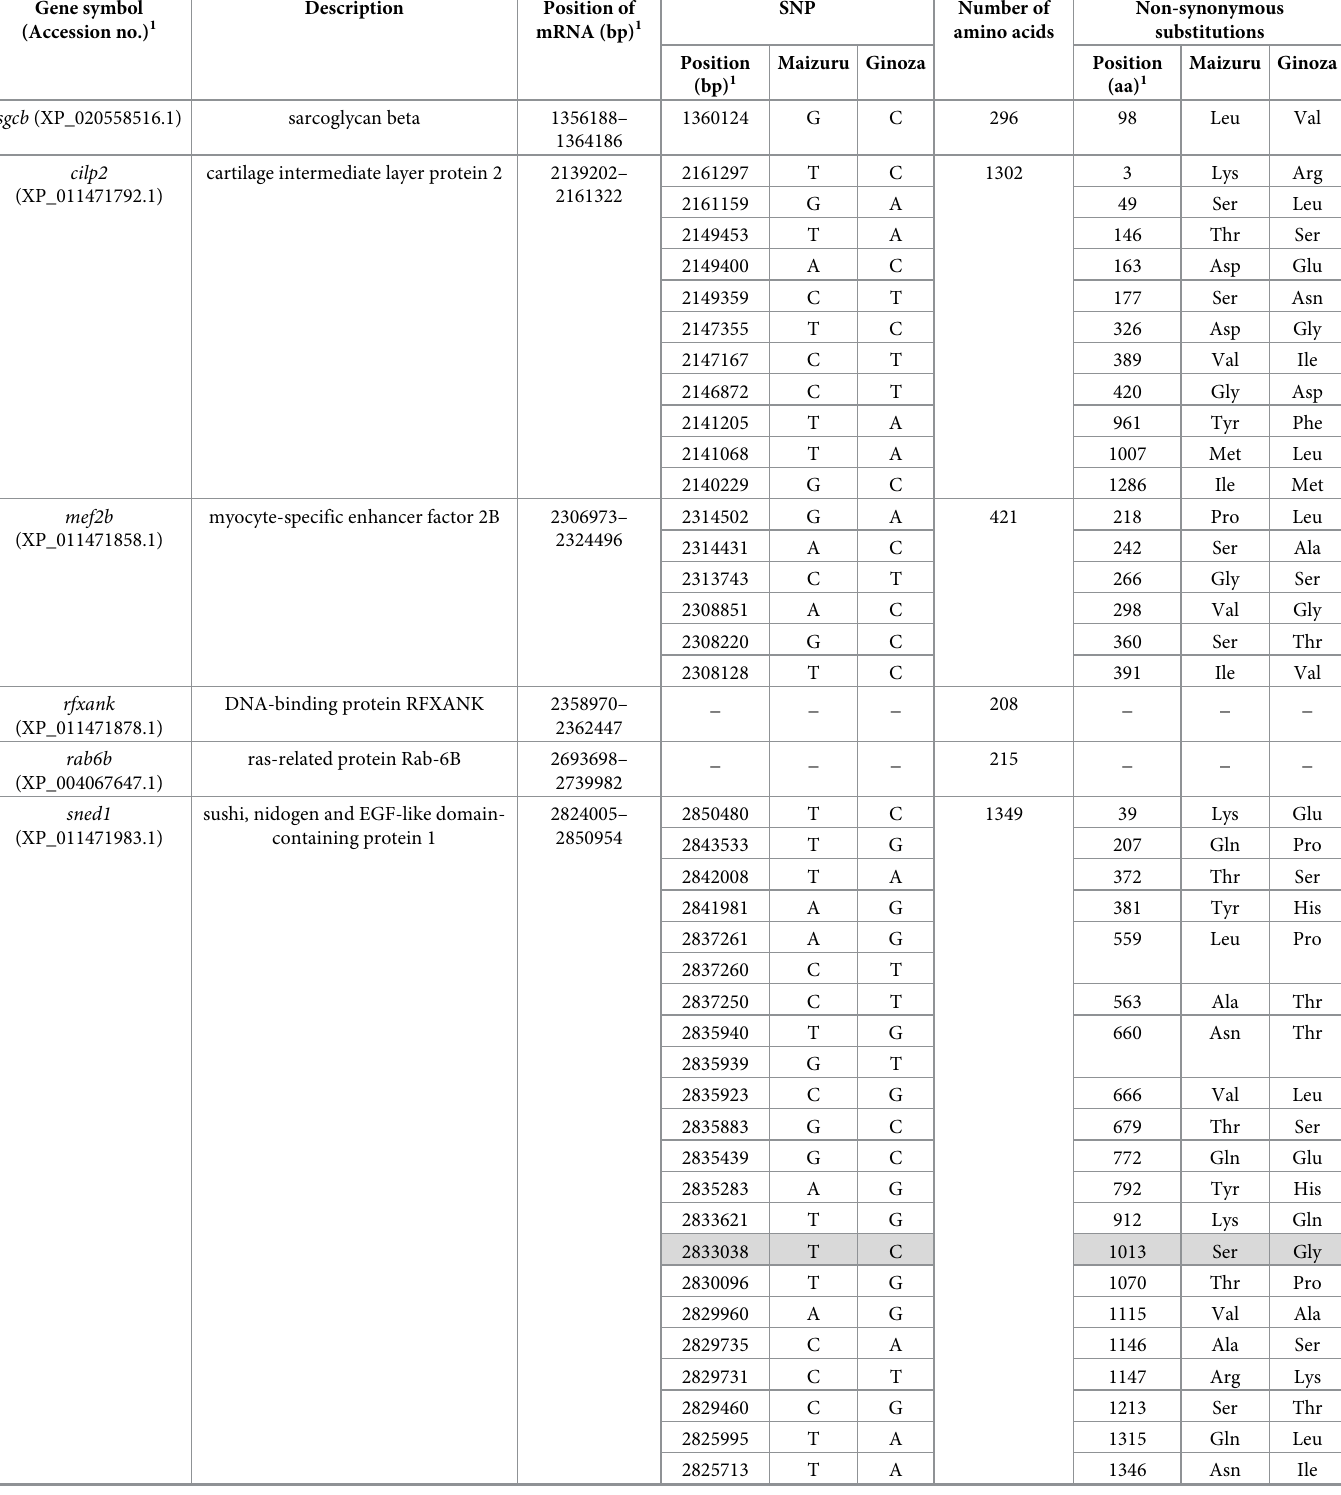
Table 2. SNPs with non-synonymous substitutions in the candidate genes in Maizuru and Ginoza. Gene symbol (Accession no.) 1